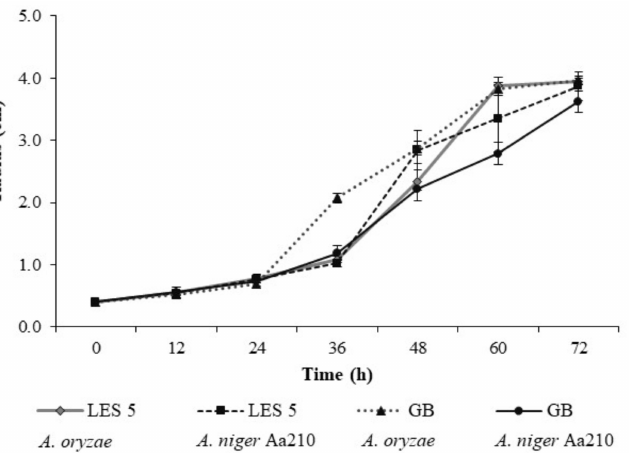
Figure 1. Radial growth (cm) of two fungi, A. oryzae and A. niger Aa210, on the substrates of two sorghum genotypes, LES 5 and GB, at 72 h.